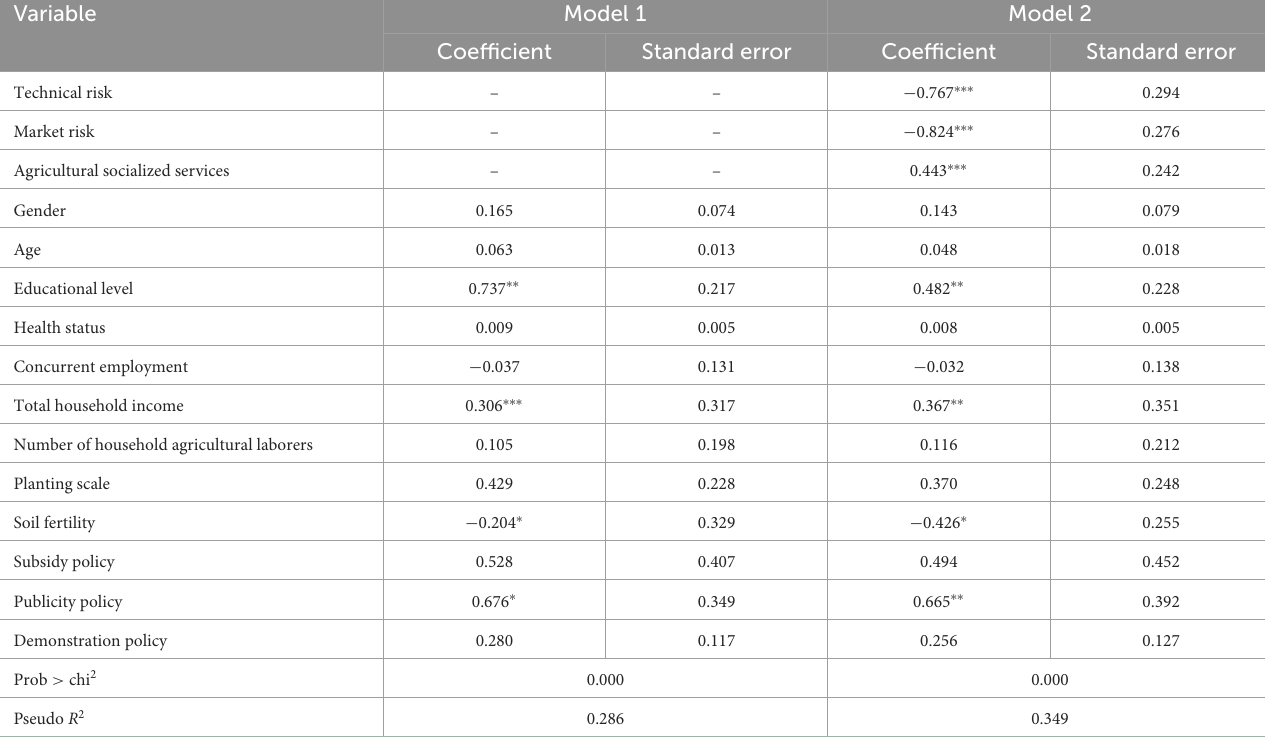
TABLE 4 Benchmark regression results.